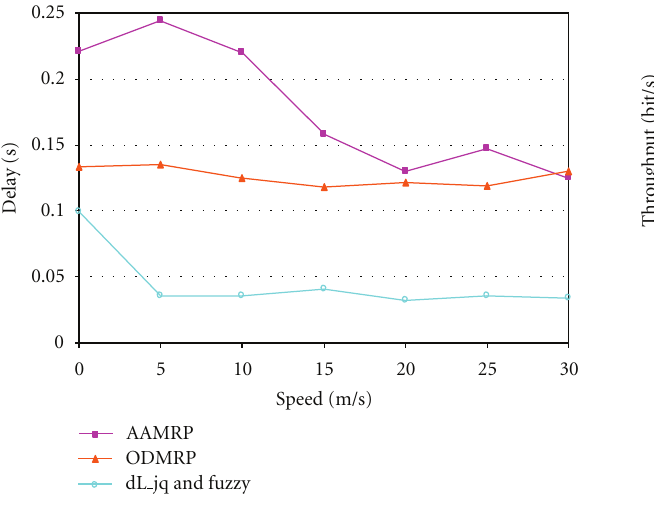
Figure 20: End-to-end delay.